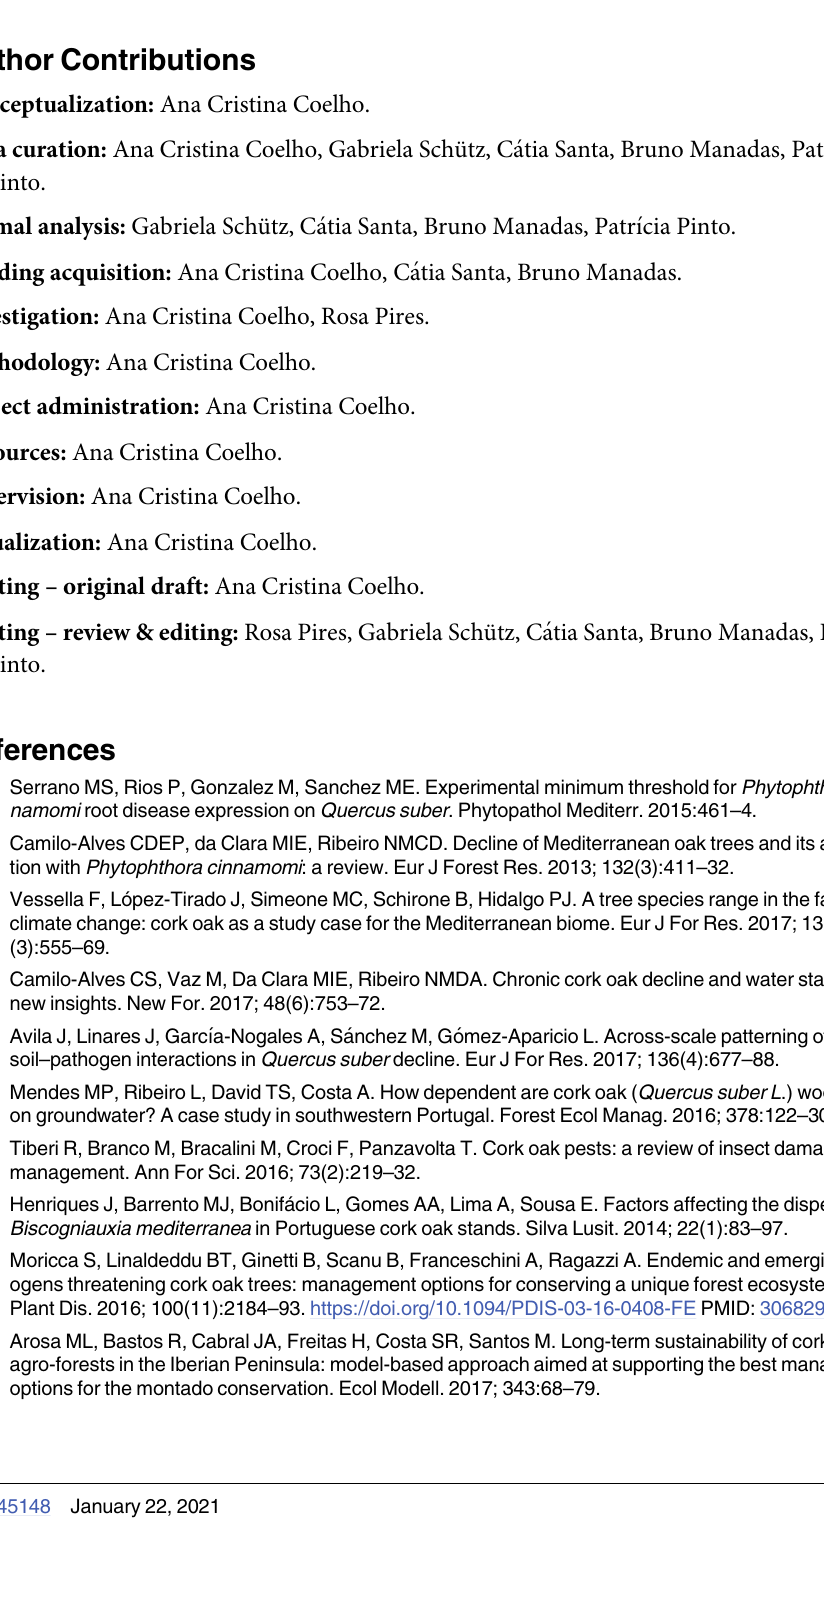
S7 Table. Significantly enriched GO cellular component groups in the list of 80 differential